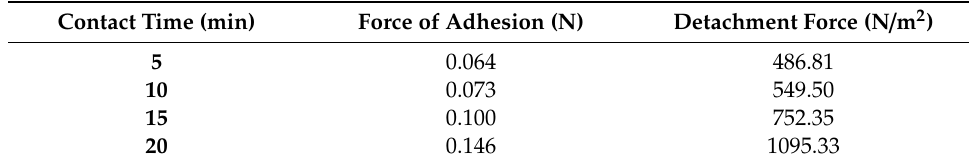
Table 3. Force of adhesion and detachment force of the tablet after di ff erent contact time on the porcine buccal mucosa ( n = 3).